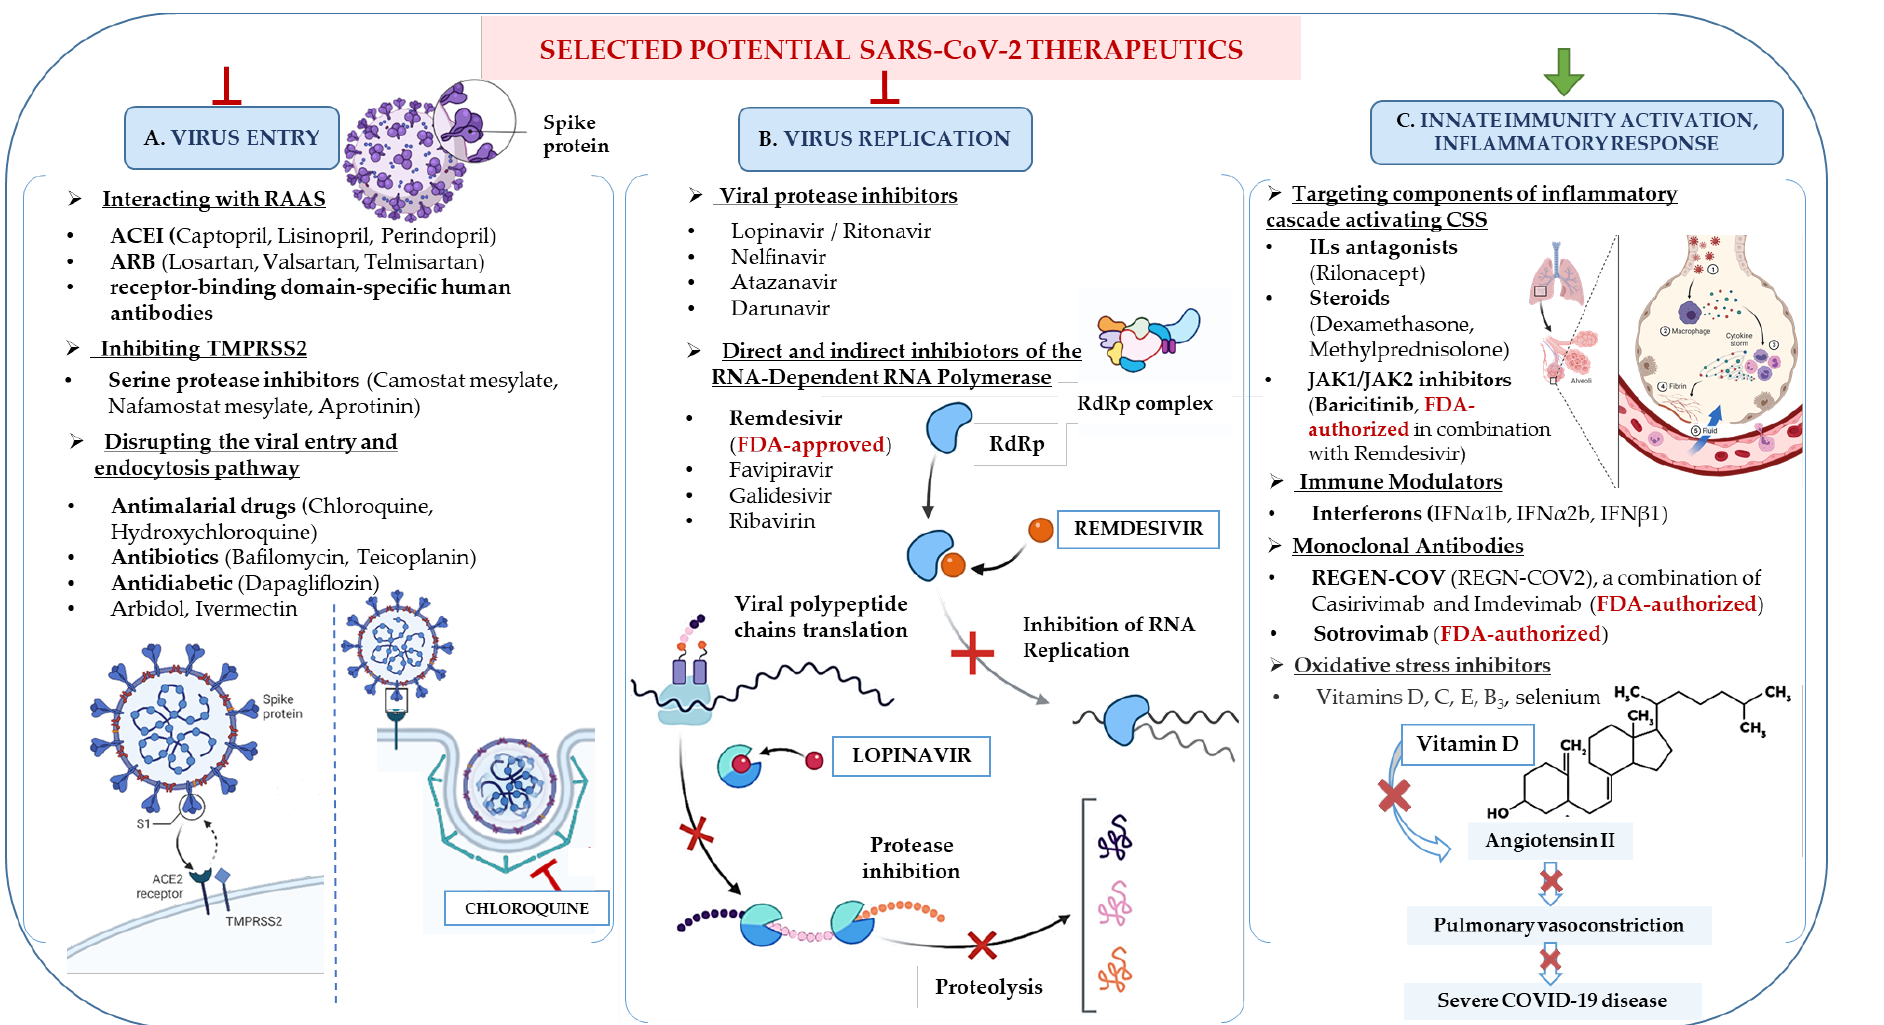
Figure 2. Potential mechanisms of SARS-CoV-2 therapeutic approaches.